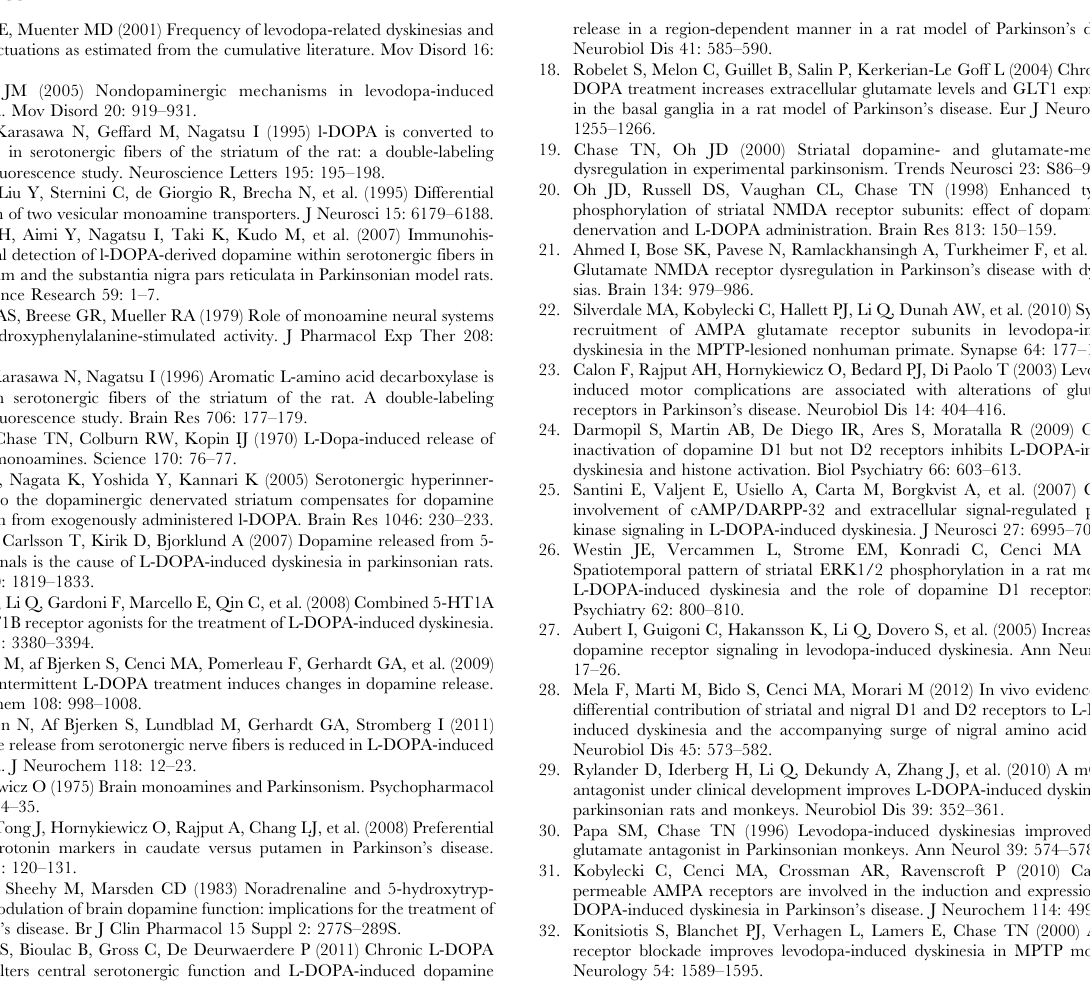
Figure S1 Calibration of microelectrode arrays. The electrodes were coated with glutamate oxidase and 1,3-phenyl- enediamine, resulting in selective recordings of glutamate (Glu,